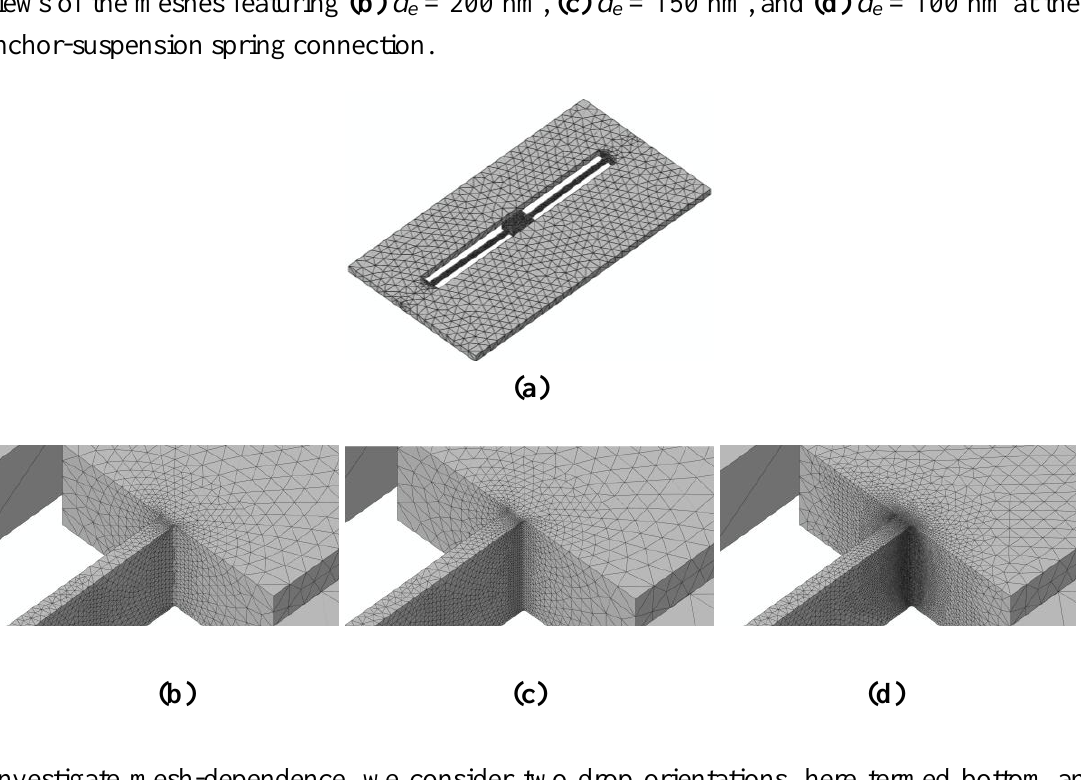
= 200 nm, (c) d = 150 nm, and (d) d = 100 nm at the e e e